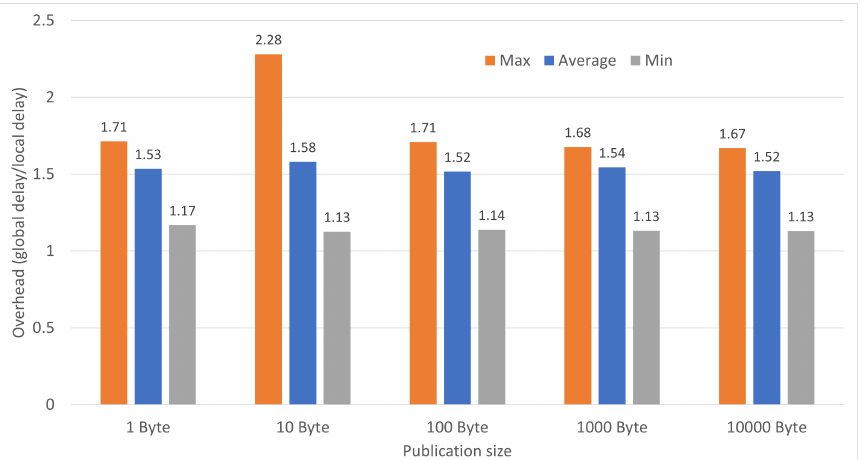
Figure 7. Ratio of delay for global client to local client as publication size increases (10 trials each).